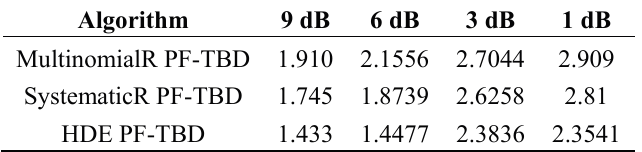
Figure 5. ( a ) Probability of existence at SNR = 9 dB for the coordinate turn (CT) model; ( b ) probability of existence at SNR = 6 dB for the CT model; ( c ) probability of existence at SNR = 3 dB for the CT model; ( d ) probability of existence at SNR = 1 dB for the CT model. Table 4. The average RMSE at different SNRs for the CT model.